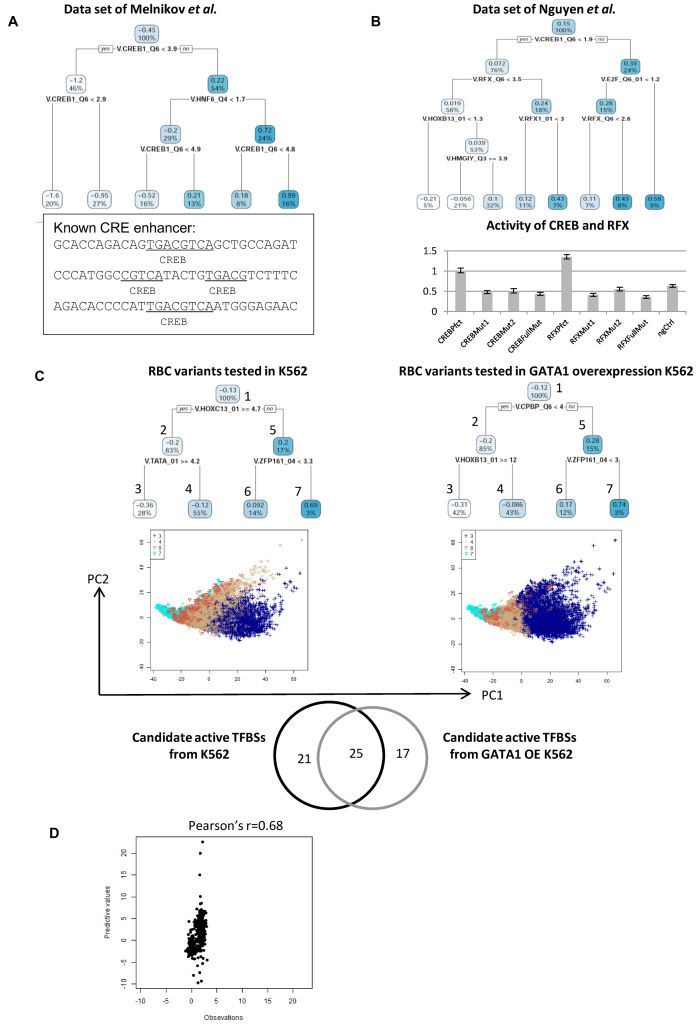
Applications of the proposed method for investigating candidate-active TFBSs. The values shown in each cluster of the regression tree indicate the average activity among samples within the corresponding cluster, and the percentages represent the sample proportions in the cluster. (A) (Upper) Candidate-active TFBS tree of the data set of Melnikov et al. (Lower) Known TFBSs in CRE enhancer described in (2). (B). (Upper) Candidate-active TFBS tree of the data set of Nguyen et al. (Lower) The average transcriptional activity of perfect motifs, two types of 2-bp mutant motifs, full mutant motifs of CREB and RFX and negative controls described in the study by Nguyen et al. ((11); Supplemental Materials). (C) (Upper) Candidate-active TFBS tree of the data set of Ulirsch et al. assayed in K562 cells and Ulirsch et al. assayed in GATA1 OE K562 cells. (Middle) Projection of TFBS enrichment scores onto PC1 and PC2 calculated by PCA for the data sets of Ulirsch et al. assayed in K562 cells and assayed in GATA1 OE K562 cells. The cluster numbers in the PCAs were identical to the index numbers of clusters shown in the candidate-active TFBS trees. (Lower) Frequencies of TFBSs that were selected by the predictive functions of Ulirsch et al. assayed in K562 and GATA1 OE K562 cells. (D) Plots between predictive values for the data set of Irie et al. estimated by the predictive functions for the Landolin et al. data set and observations from the Irie et al. data set.